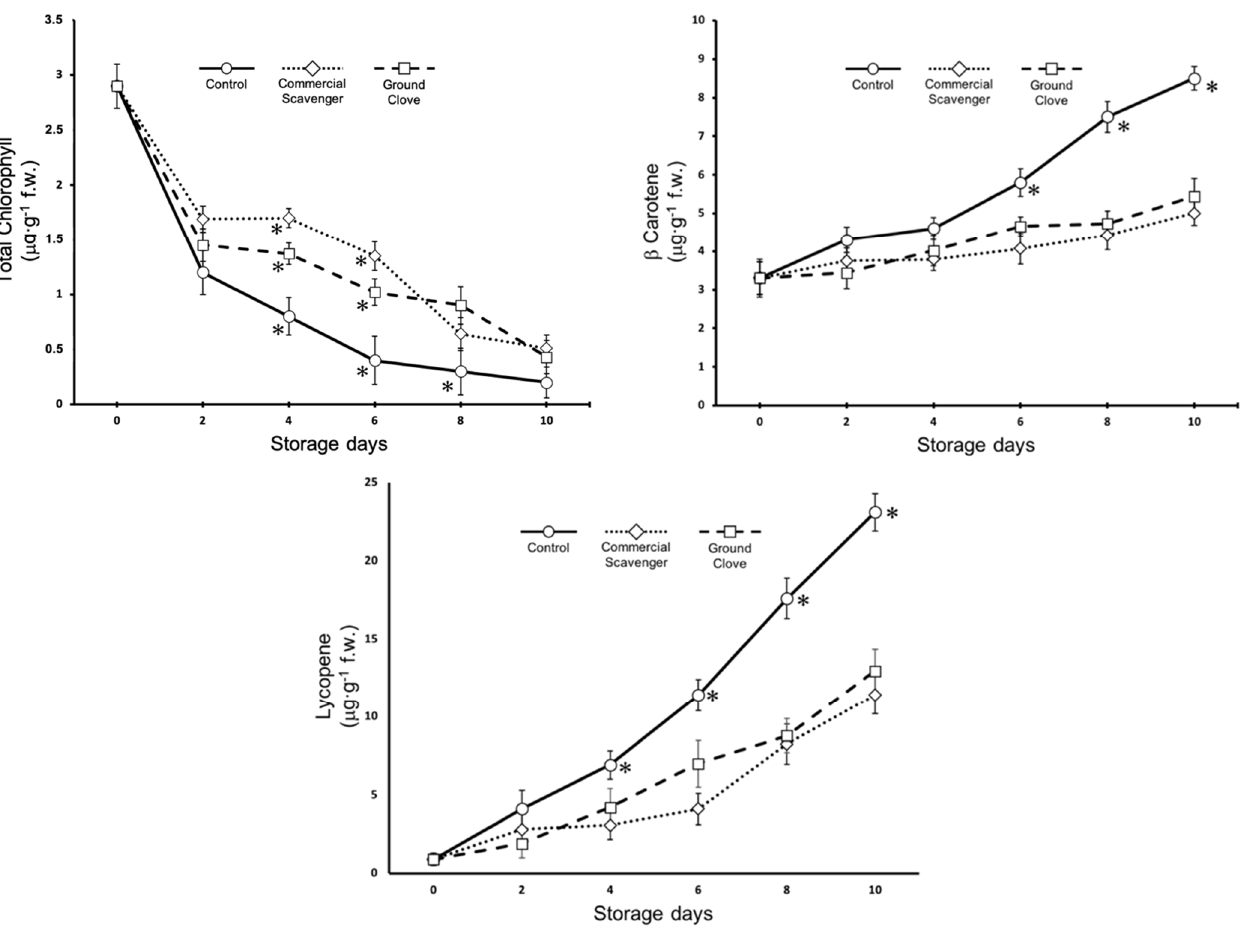
Figure 3. Evolution of total chlorophyll, β -carotene and lycopene in Raf tomatoes packaged and not packaged (control) with the Commercial scavenger or Ground clove. Vertical bars show the standard error (SE) ( n = 15). ∗ indicates significant differences within treatments according to the LSD test at p < 0.05. The lack of a symbol indicates no differences.